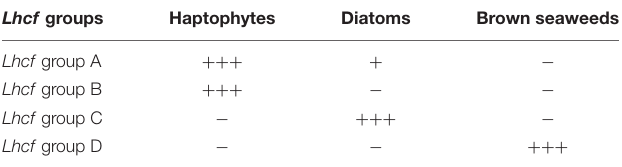
TABLE 1 | Proposal for a new classification of Lhcf. Lhcf